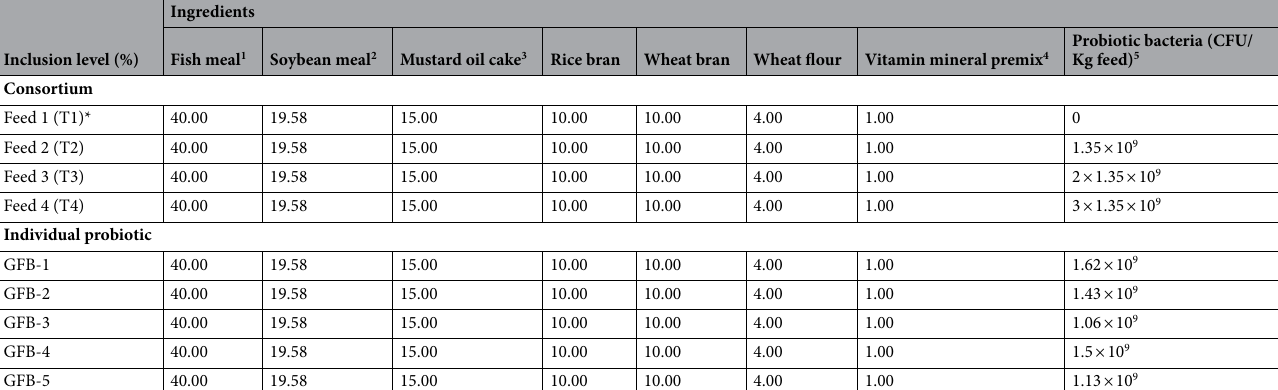
Table 4. Composition of experimental feed supplementing with the graded level of consortium and individual of probiotic bacterial strain for the rearing of B. gonionotus. *Denotes control 1 Locally purchased, crude protein 70%, crude lipid 9% 2 Mega Feed Limited, Bangladesh, crude protein 49%, crude lipid 20% 3 Locally purchased, crude protein 40%, crude lipid 20% 4 Vitamin premix (mg/kg diet): thiamin, 25; riboflavin 20; pyridoxine 21; cyanocobalamine, 0.03; folic acid 5; calcium pentothenate, 45; inositol, 100; niacin 100; biotin 0.1; starch, 3400; ascorbic acid, 100; Vitamin A, 100; Vitamin D, 20; Vitamin E, 50; Vitamin K, 12 5 Extracted and isolated from gut of B. gonionotus